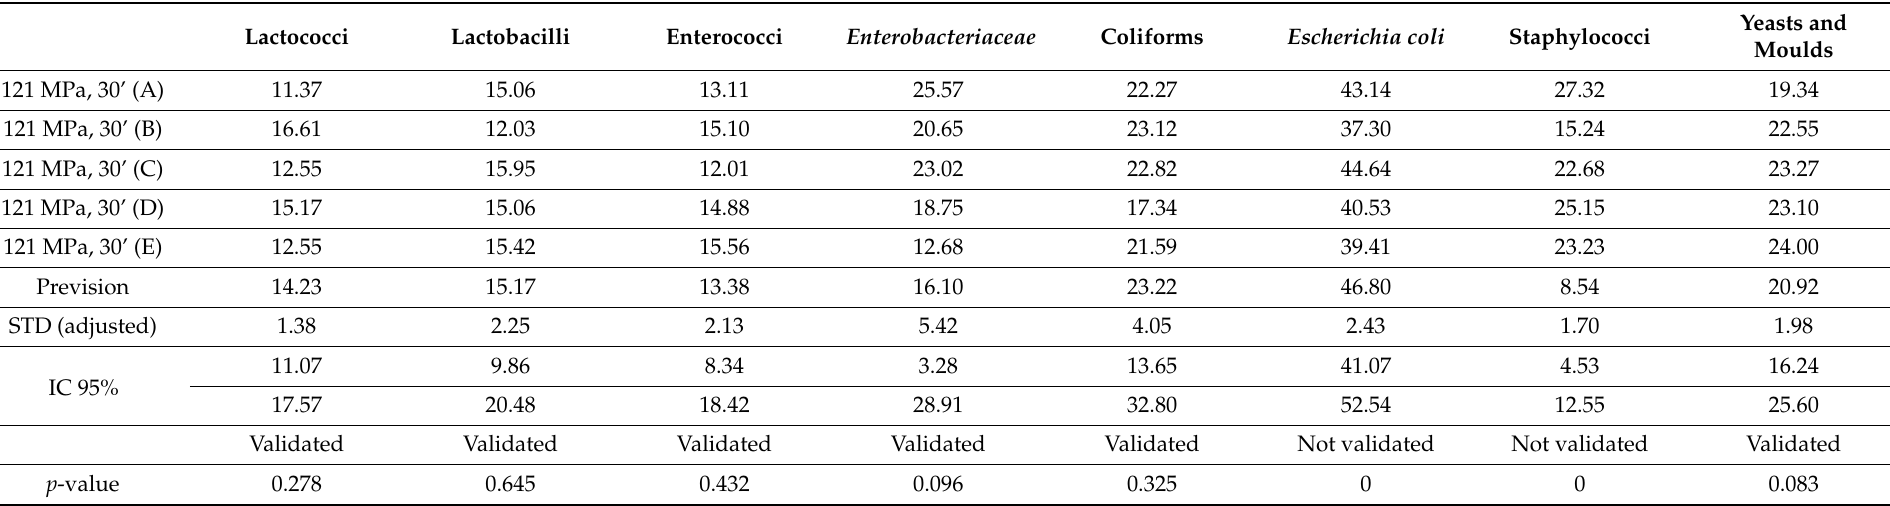
Table 3. Results for model validation: microbiota viable cell numbers were normalized and expressed in inactivation percentage (log reductions/log counts untreated milk samples). Prevision values and adjusted standard deviation determined by Minitab